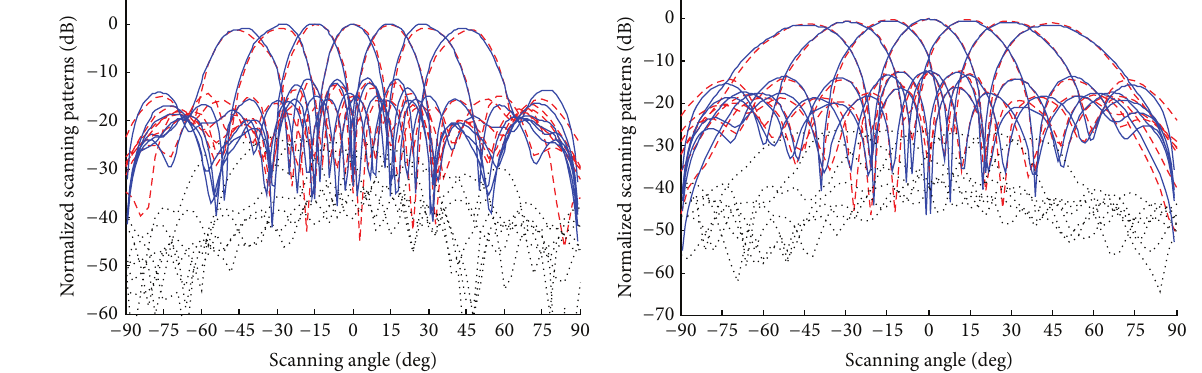
(a) Radiation pattern of the TCDA-IB array at ± 45, ± 30, ± 15, and 0deg from broadside at 2.4GHz